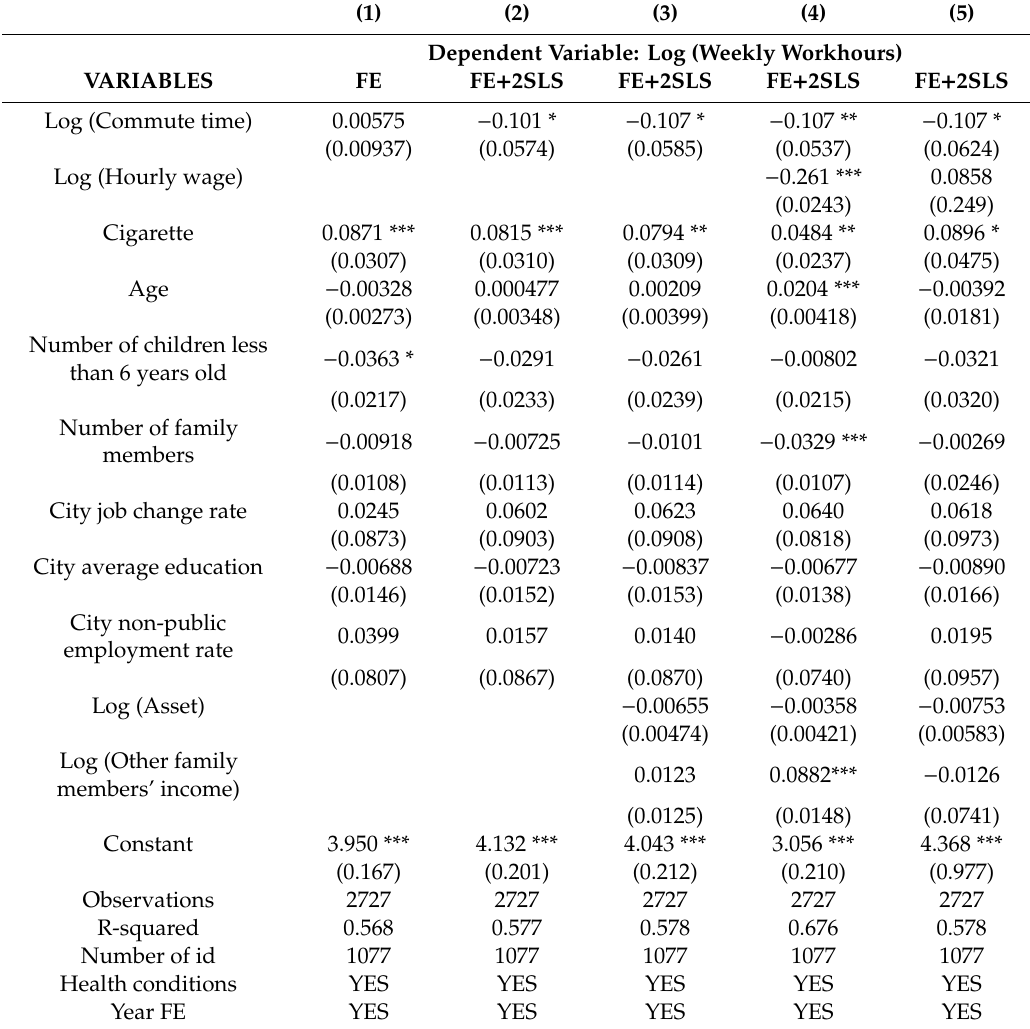
Table 6. E ff ect of commute time on labor supply—weekly